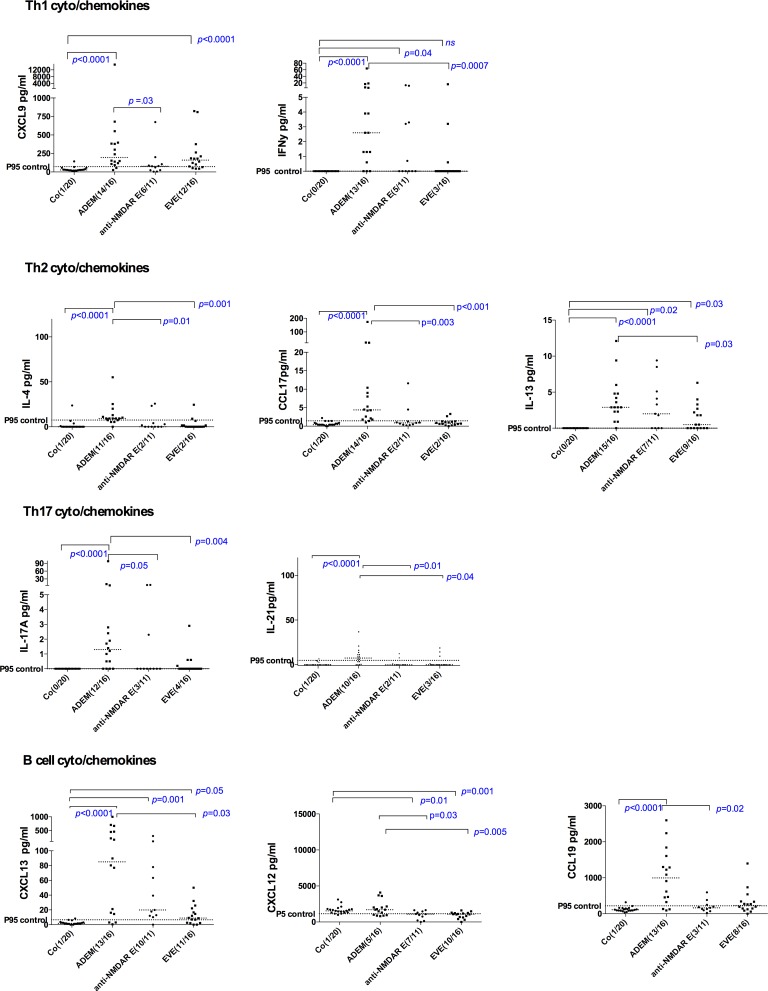
CSF cytokine/chemokine levels that were more elevated in ADEM compared to EVE and anti-NMDAR E.Th17 (IL-21, IL-17A) and Th2 (CCL17, and IL-4) related cytokine/chemokines showed statistically significant elevation in ADEM compared to both EVE and anti-NMDAR E. CXCL12 showed paradoxical decrease in EVE and anti-NMDAR E, in contrast to elevation noted in ADEM.